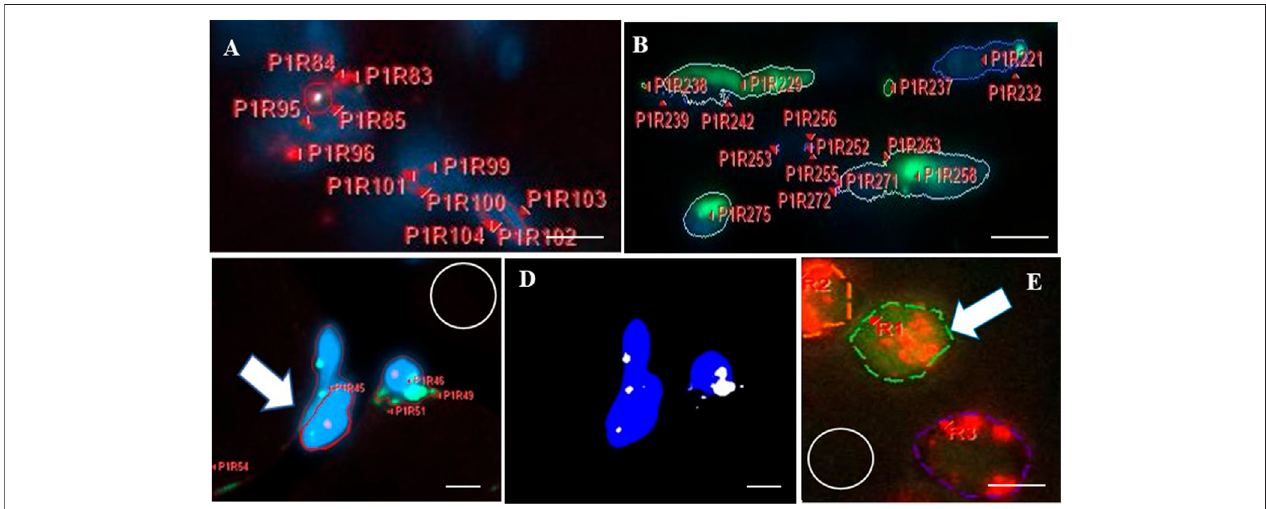
FIGURE 4 | Analysis of in situ hybridization (ISH) signals and areas of colocalization using Celleste software. After imaging and software calibrations for brightness and magni fi cation, fl uorescent regions in each image fi eld were viewed. The program automatically detected, color-outlined, coded, and labeled each fl uorescent site with a unique alpha-numeric identi fi er, before counting sites and measuring each for intensity and maximum diameter. (A,B) show two representative highly magni fi ed fi eldsofmuscletoillustrate thelabeling and counting feature ofthesoftwareapplied toasingle fl uorochrome, bothat day 0aftermuscle-crush injury.Fieldsdisplay numerous sites outlined for red fl uorescence (A) , detecting S100B (outlined by red lines), or green fl uorescence (B) , detecting Sema3A (outlined by green lines), with alpha-numeric labels. Fluorescent sites varied from tiny to large. Each irregularly shaped region of fl uorescence is counted as a single expression site, according to speci fi cationsoftheRNAScopev2multiplextechnology.Theintensity(arealdensity)ofeachregionwasmeasured(notincludingnon- fl uorescentpixelsinsideanoutline). The maximum diameter ofeach fl uorescent region was measured in pixels, and data for each site in every imaged fi eld (10 per section) were recorded and compiled in a spreadsheet. (C) Shows three regions of blue fl uorescence (a test area of prominent 4 ′ ,6-diamidino-2-phenylindole-labeled nuclei) that are outlined in red (one is indicated by the white arrow). Overlapping areas of green fl uorescence were identi fi ed using the “ smart segmentation ” tool. (D) Shows the application of the Celleste “ colocalization ” featureused toidentifyand measure thespatialoverlap (area) betweentwo (ormore) different fl uorescent colorlabels. Inthis example, the colocalization feature identi fi ed regions of overlap between blue and green in panel (C) and indicates those as the white regions shown in (D) . Regions of colocalization were subsequentlycountedbythesoftware. (E) Showsasmallhighlymagni fi edareafroma fi eldimagedforISHsignalsinarepresentativemusclesectionshowingthreesites that were outlined (dashed red lines) for red fl uorescence. One of those sites (white arrow) overlaps and is surrounded by green fl uorescence from a second probe (dashedgreenoutline).Whitecirclesin (C,E) indicateregionsusedtomeasurethebackgroundintensity.Ineach fi eld,backgroundintensitywassubtractedfromintensity measurements of fl uorescence. Bars indicate 1.8 µm (A,B,E) or 3 µm (C,D)